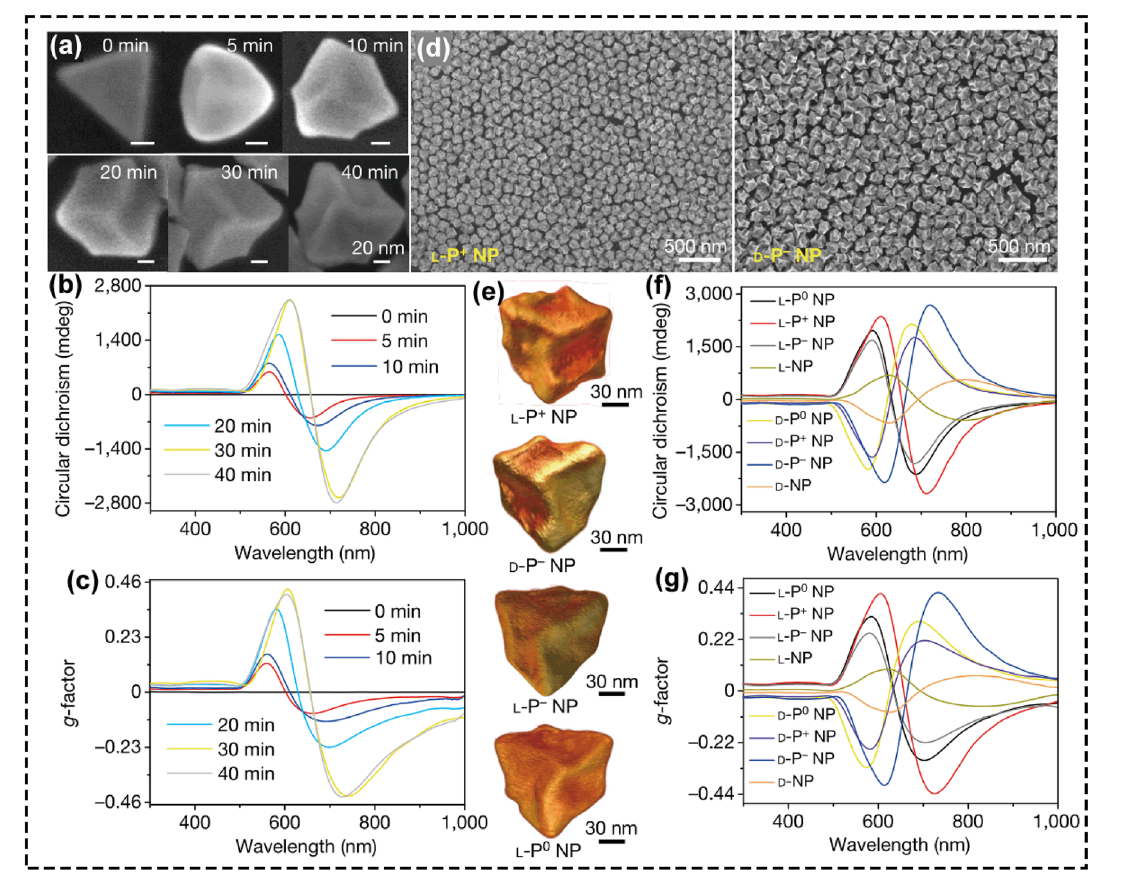
Fig. 3 Morphology and spectroscopy of CPL-mediated chiral gold nanostructures. Scanning electron microscope (SEM) images a , circular dichroism spectra b and g-factor spectra c of L-P+ NPs after 0, 5, 10, 20, 30, and 40 min of illumination at 594 nm with 84 mW cm−2. d SEM images of L-P+ NPs and D-P− NPs. e TEM tomography images of L-P+, L-P−, D-P−, and L-P0 NPs. Circular dichroism spectra f and g-factor spectra g of NPs synthesized under different light conditions in the presence of CYP dipeptides: L-P+ NPs (under LCP illumination), D-P− NPs (under RCP illumination), D-P+ NPs (under LCP illumination), L-P− NPs (under RCP illumination), L-P0 NPs (under LP illumination), D-P.0 NPs (under LP illumination), L-NPs (without light illumination), and D-NPs (without light illumination) (reproduced with permission from Ref. [79]. Copyright 2022 Nature publishing